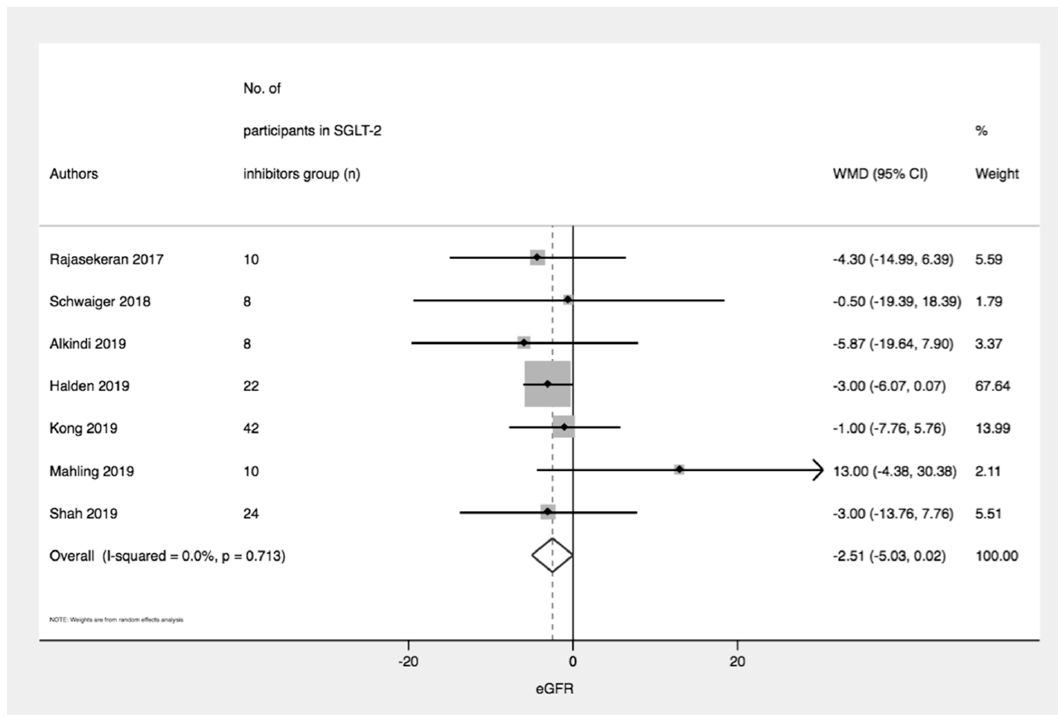
Figure 2. Plot displaying the pooled weighted mean difference of estimated glomerular filtration rate (eGFR), comparing levels at baseline and end of study.